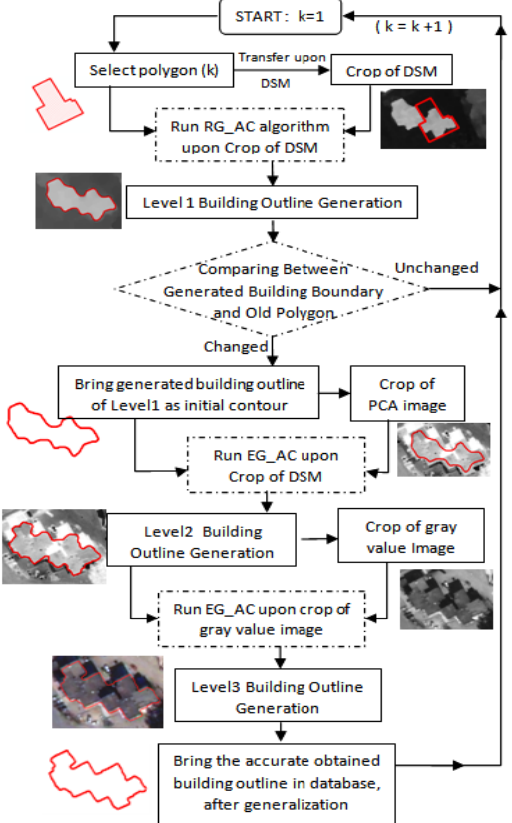
Figure 2. Flowchart of automatic building map updating